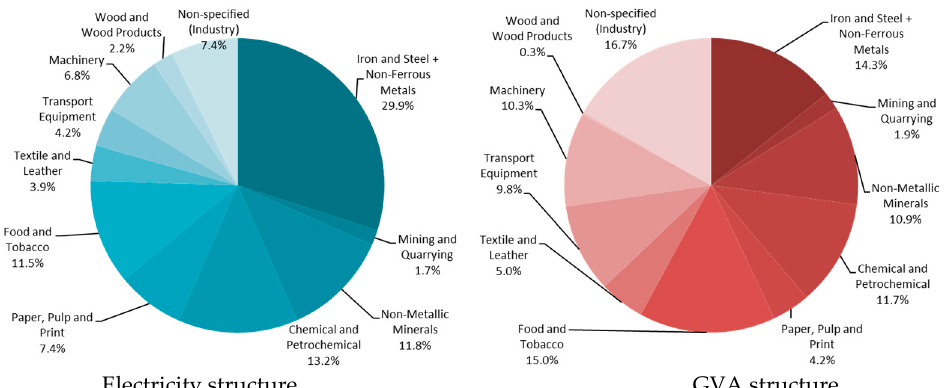
Figure 7. Shares on total final consumption of electricity. Source: Own calculation with Eurostat’s data.